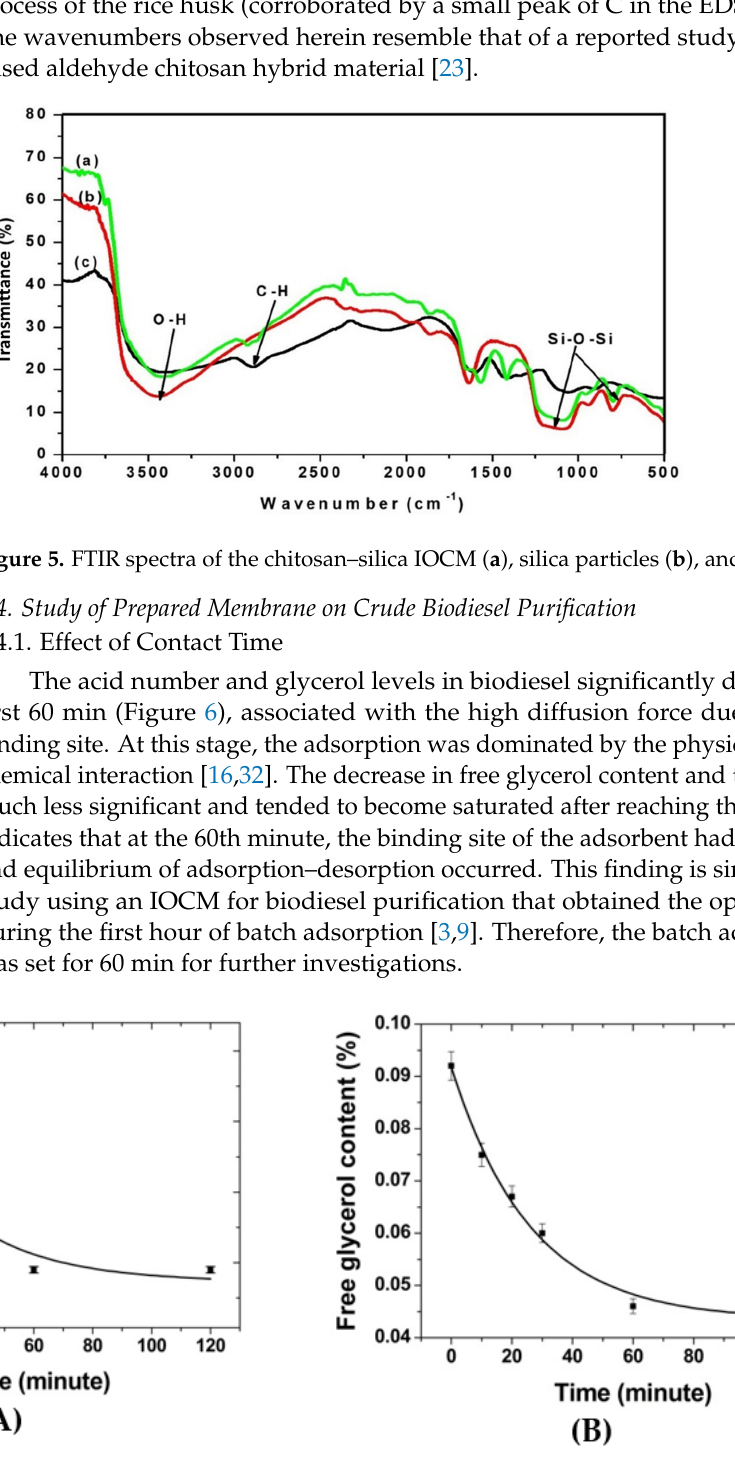
Figure 4. EDS data of the IOCMs containing silica particles from rice husk.